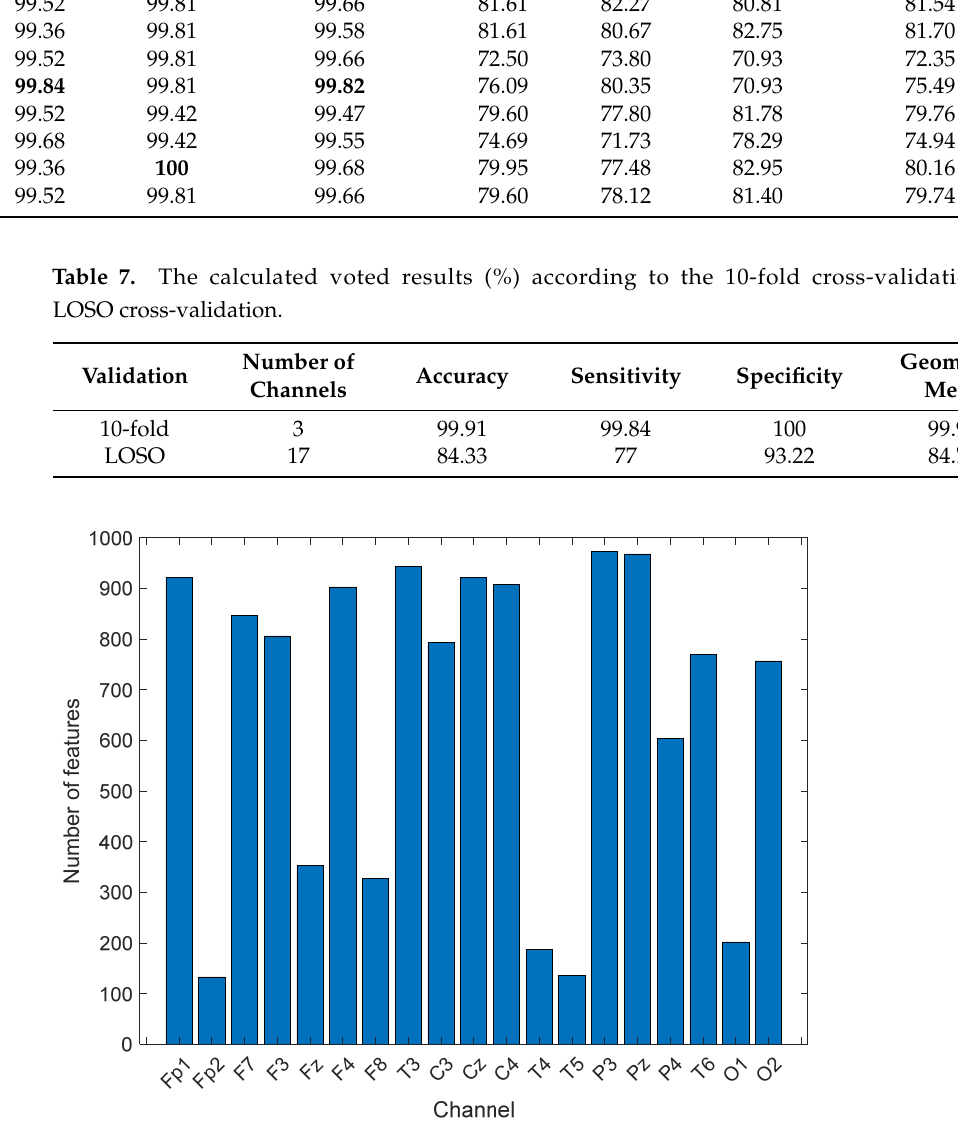
Figure 4. The lengths of the optimal feature vectors chosen by INCA.